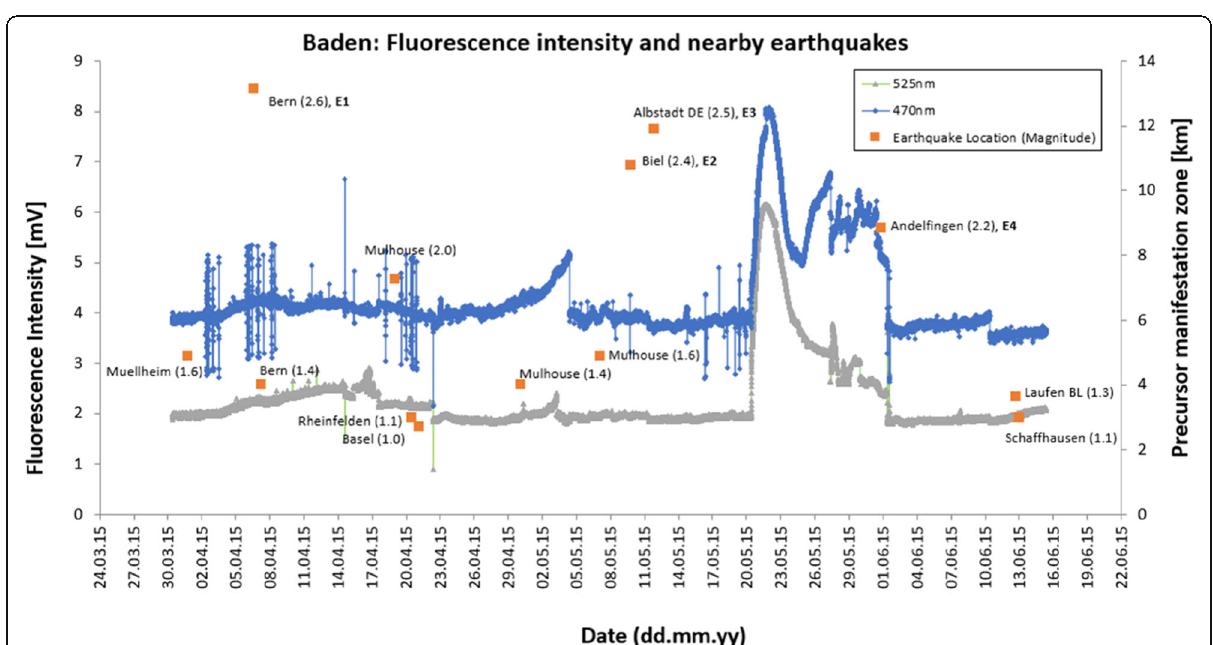
Fig. 4 Diagram of the monitored Fluorescence intensity of the thermal water in Baden (B) over the measuring period. The fluorescence intensity at wavelength 470 nm is presented in the blueish curve whereas the greyish curve presents the fluorescence intensity at 525 nm. The orange squares depict the registered earthquakes with the location and the magnitude in brackets. The earthquakes are scaled depending on their precursor manifestation zone, which was calculated by Eq.